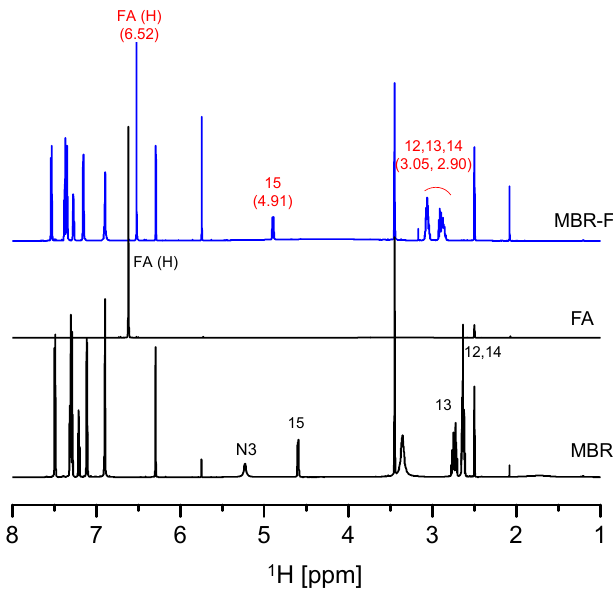
Figure 3. Solution-state nuclear magnetic resonance ( 1 H-NMR) spectra for MBR-FA co-amorphous, MBR crystalline solid, and FA (numbers on peaks relate to numbers in Figure 1a structure and peak location) (DMSO- d 6 ).